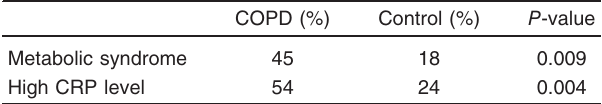
Table 4 The prevalence of metabolic syndrome and high C-reactive protein levels in patients and controls